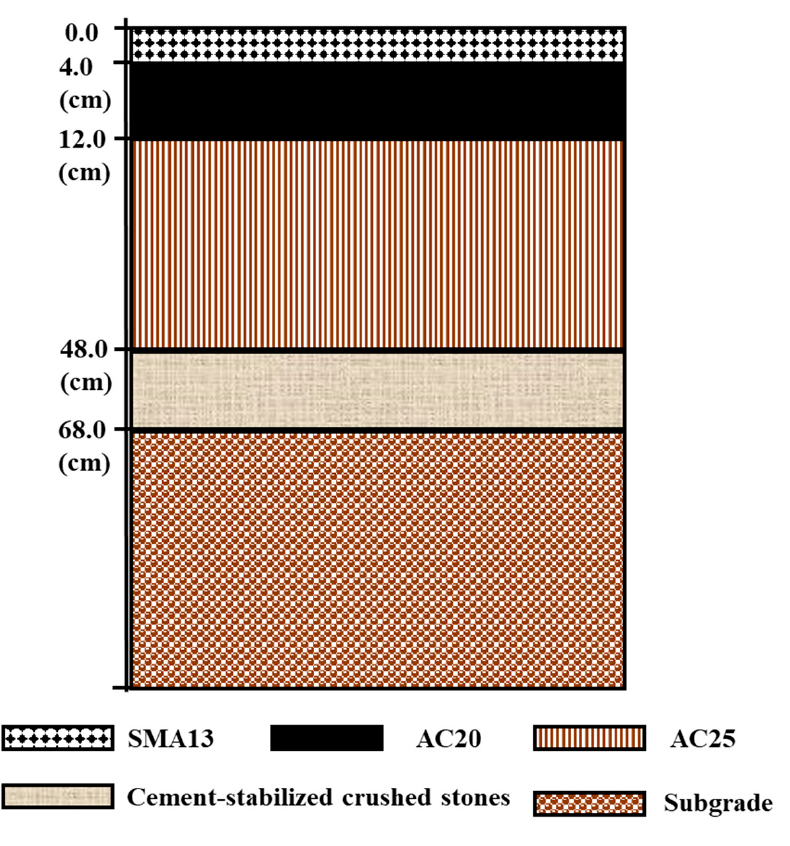
Figure 3. Structure of test section.